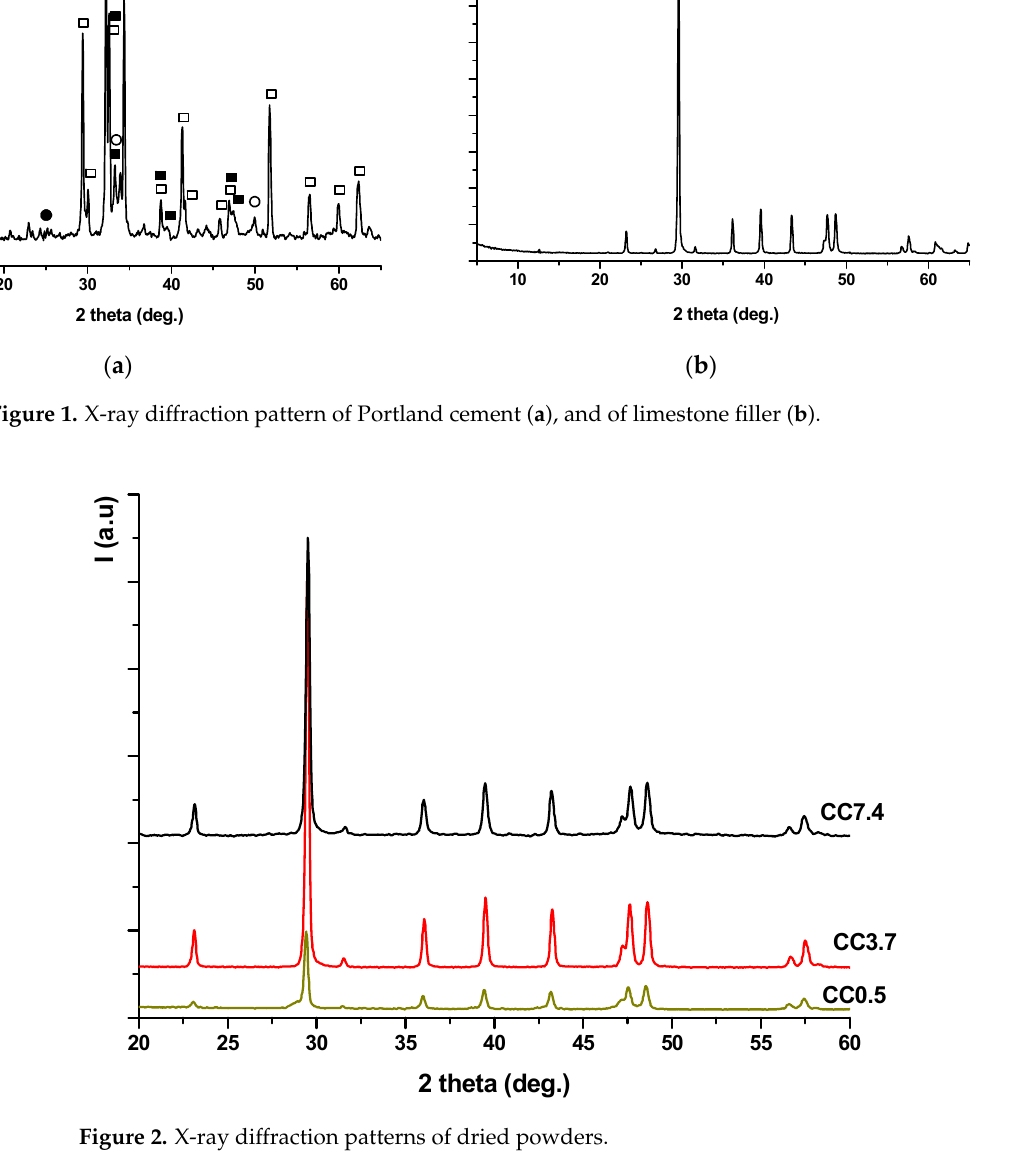
Figure 2. X-ray diffraction patterns of dried powders. The differential thermal analysis (DTA) curves of dried powders (Figure 3) show an intense endothermic effect with maximum at 748–773 ◦ C, with a corresponding weight loss assessed on TG curves between 650–800 ◦ C; this effect is attributed to the CaCO 3 decarbonation [39] and is in good correlation with the results obtained by XRD analysis, previously presented. Because decarbonation process occurs below 800 ◦ C, it is suggested that carbonate phases are microcrystalline [39].